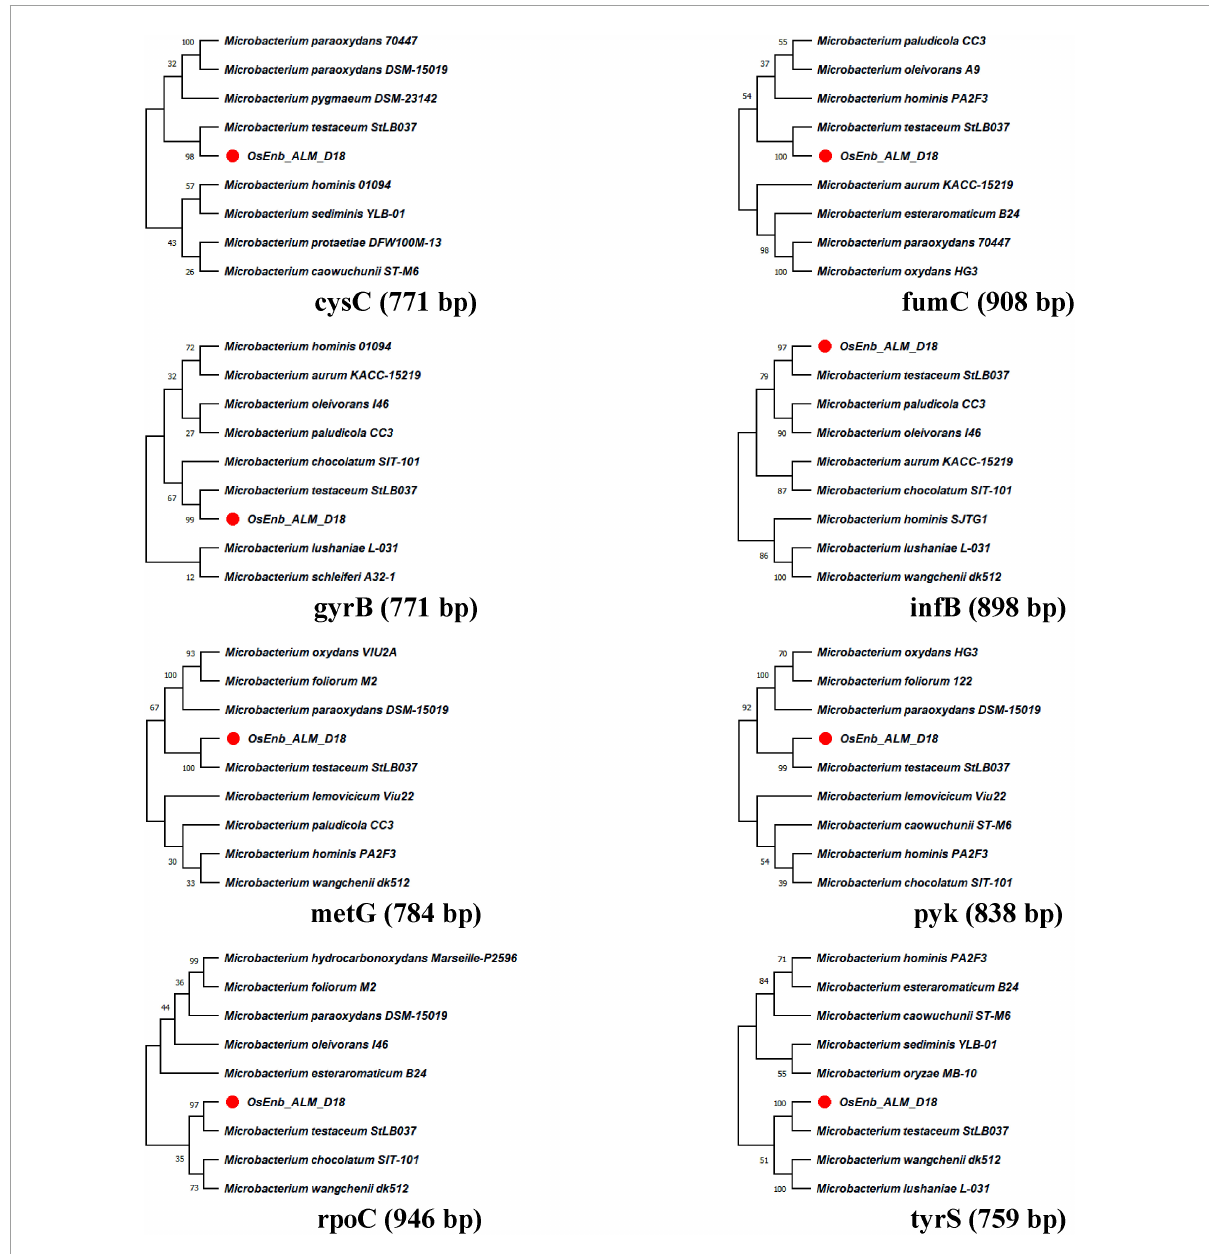
FIGURE1 Molecular phylogenetic analysis of Microbacterium species by maximum likelihood method. The evolutionary history was inferred by using the Maximum Likelihood method and the Hasegawa-Kishino-Yano model (Hasegawa et al., 1985). The % of trees in which the associated taxa clustered together is shown above the branches. This analysis involved the nucleotide sequence of nine isolates. Evolutionary analyses were conducted in MEGA11 (Kumar et al.,